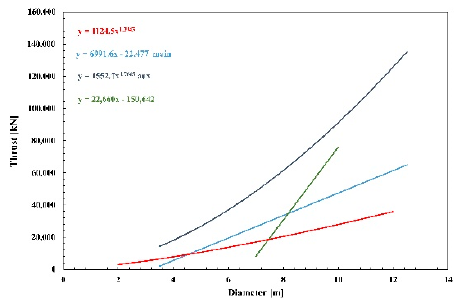
Figure 27. Trend of the thrust vs. the diameter based on data collected from the analysis of double shield TBMs. In red, the experimental model proposed in this study; in light blue main thrust, in dark blue auxiliary thrust representing the experimental model of [42]; and in green, the model proposed by [43].